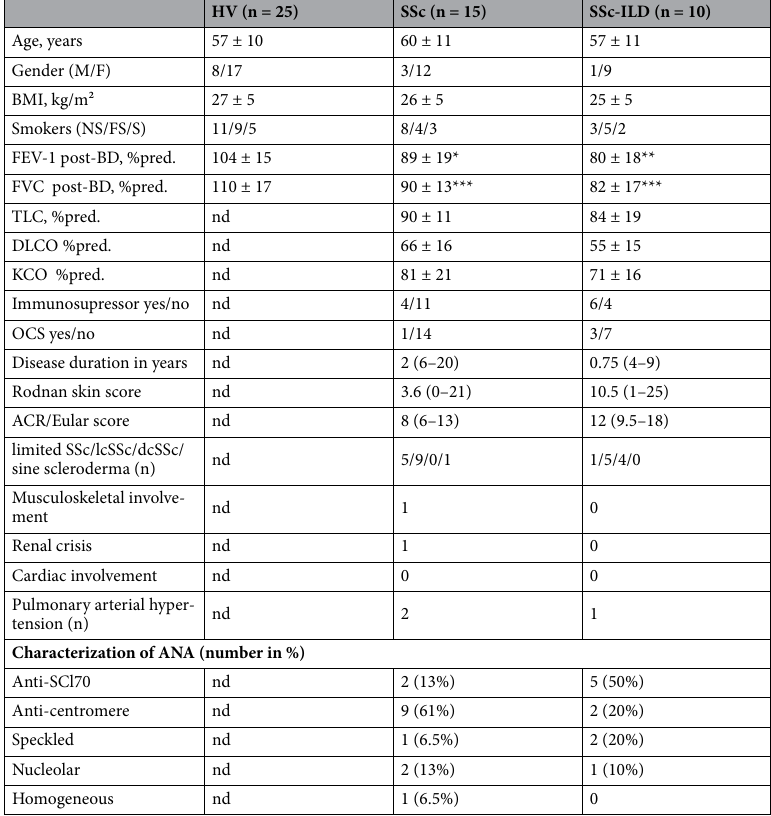
Table 1. Subjects characteristics. Data are expressed in mean ± standard deviation when the distribution is normal and in median (interquartile range) when the distribution is non-parametric. nd no data, lcSSc limited